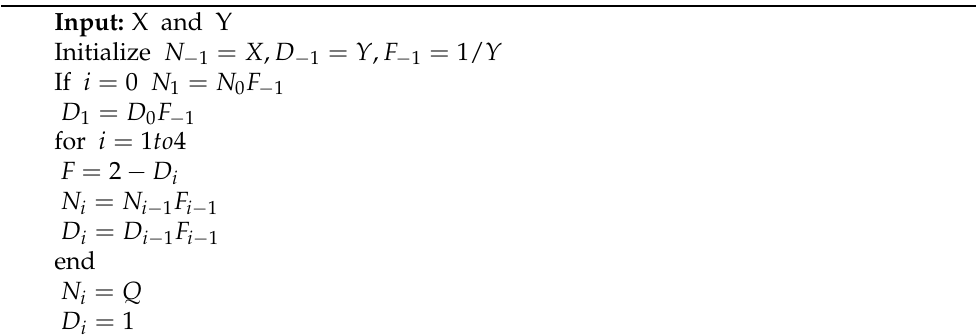
Algorithm 4: Goldschmidt Division Algorithm for floating-point number with